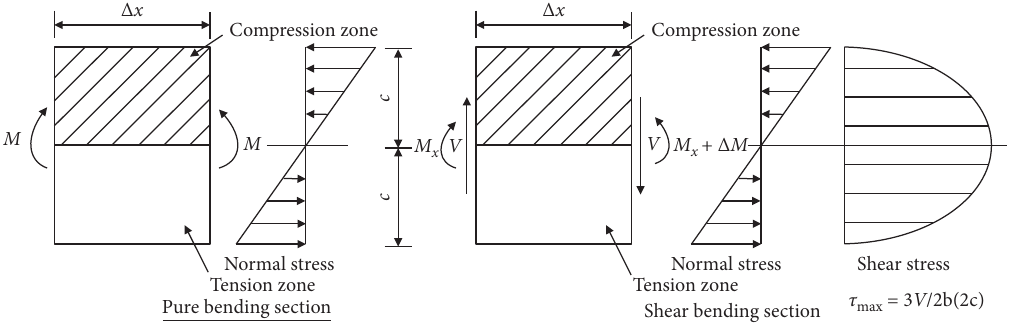
Figure 2: Stress distribution in the equivalent rectangular beam composed with ideal elastic material.